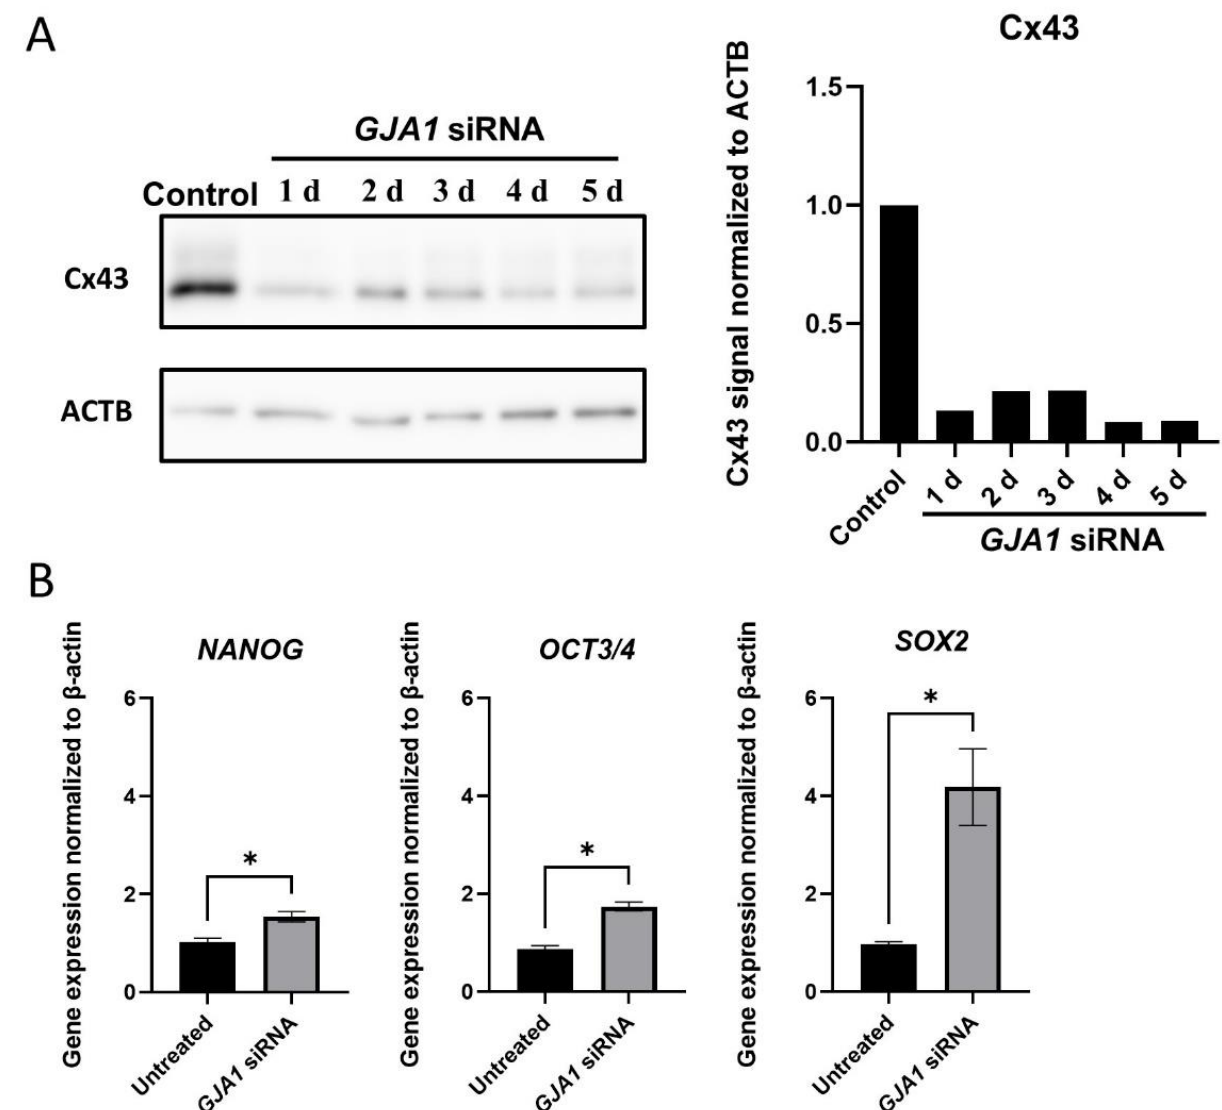
Figure 4. GJA1 knockdown in Muse cells. ( A ) Western blot of untreated-Muse cells (control), and Muse cells 1 – 5 days after GJA1 siRNA transfection. ACTB was used as a housekeeping control. The bar graph shows the protein signal intensity, as quantified using ImageJ software, and normalized to ACTB levels; ( B ) qPCR for pluripotency markers ( NANOG , OCT3/4 , and SOX2 ) 4 days after GJA1 siRNA transfection. Each expression level was normalized by ACTB ( n = 4). *: p < 0.05. Mann Whit- ney test was used for statistical analysis. Data are shown as the mean ± SEM.